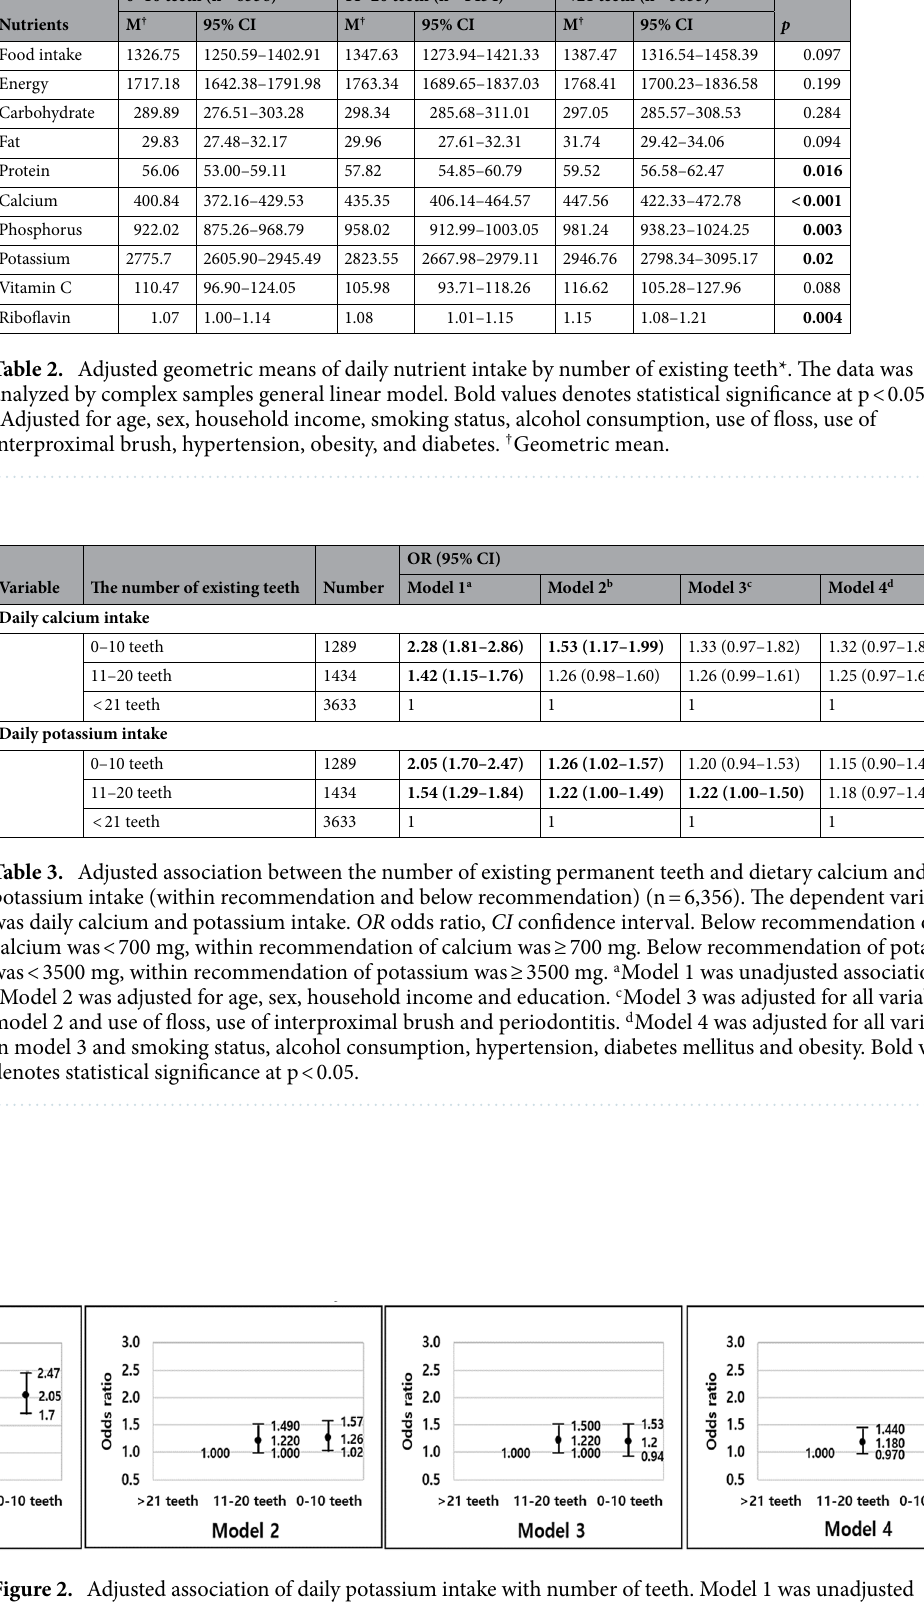
Figure 2. Adjusted association of daily potassium intake with number of teeth. Model 1 was unadjusted association, model 2 was adjusted for age, sex, household income and education, model 3 was adjusted for all variables in model 2 and use of floss, use of interproximal brush and periodontitis, and model 4 was adjusted for all variables in model 3 and smoking status, alcohol consumption, hypertension, diabetes mellitus and obesity. Diamond denotes and bar denotes 95% confidence interval. Diamond with value 1 represents the